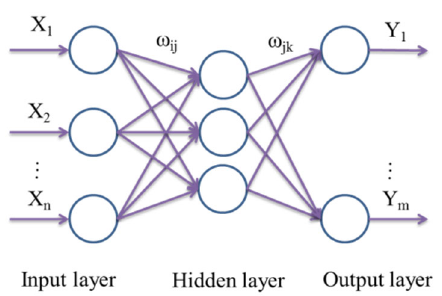
Figure 4. Topological structure of neural network.